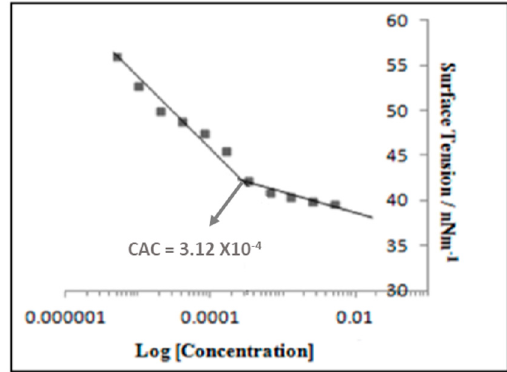
Figure 2. Plot of critical aggregation concentration (CAC) determination of amphiphile 24 using surface tension measurement. Table 1. CAC of amphiphiles determined using surface tension method.